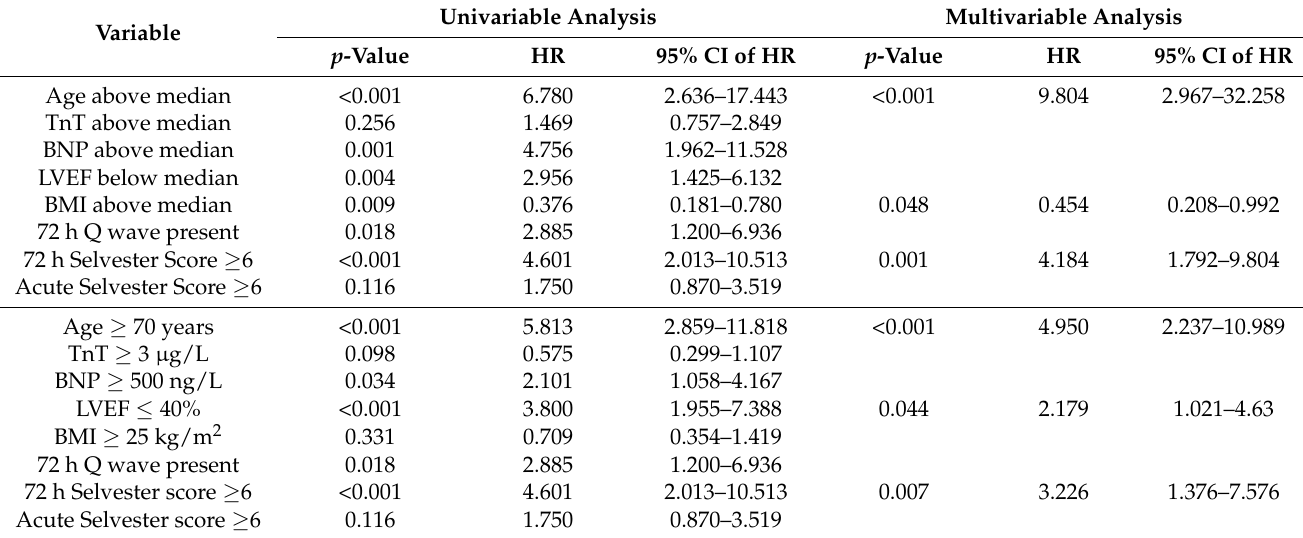
Table 3. Predictors of death in STEMI patients treated with primary coronary